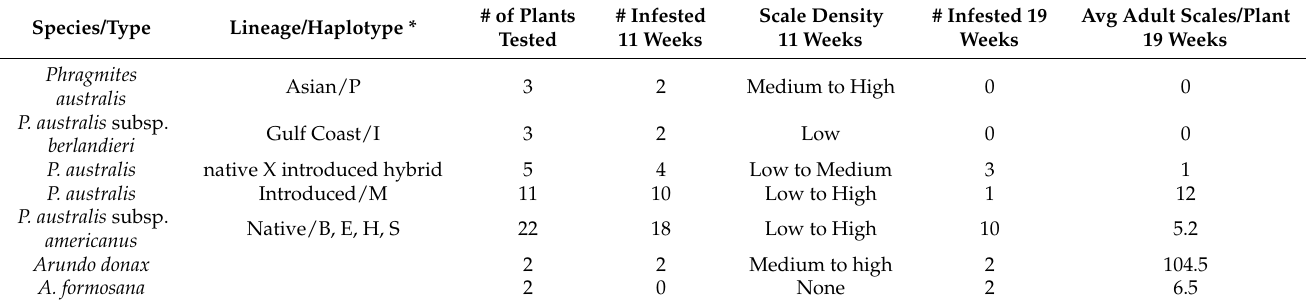
Table 2. Host range trials of adventive Rhizaspidiotis donacis focusing on haplotypes of Phragmites australis , the closest relative of Arundo donax in North American, and two horticultural grass species. Trials were conducted in a greenhouse at University of California, Santa Barbara. Plants were checked for establishment at 11 weeks and 19 weeks after introduction of R. donacis crawlers. For the 11-week scale density counts, low = 0–10, medium = 11–30, and high ≥ 30. * Designations follow Saltonstall [41], Saltonstall and Hauber [48].